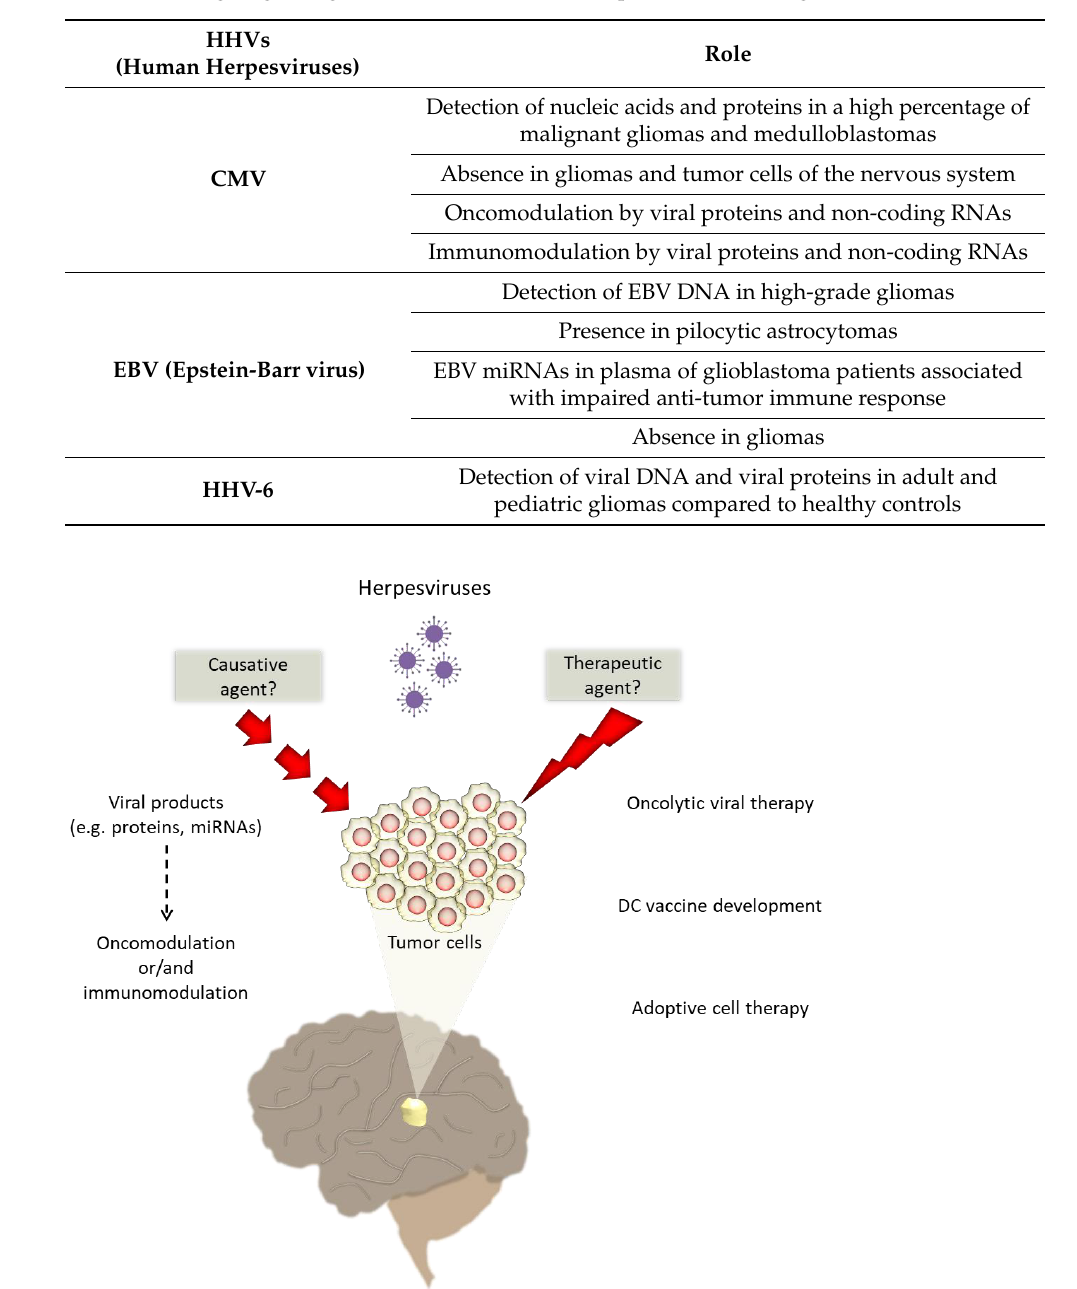
Table 3. Findings regarding the controversial role of herpesviruses in malignant brain tumors.